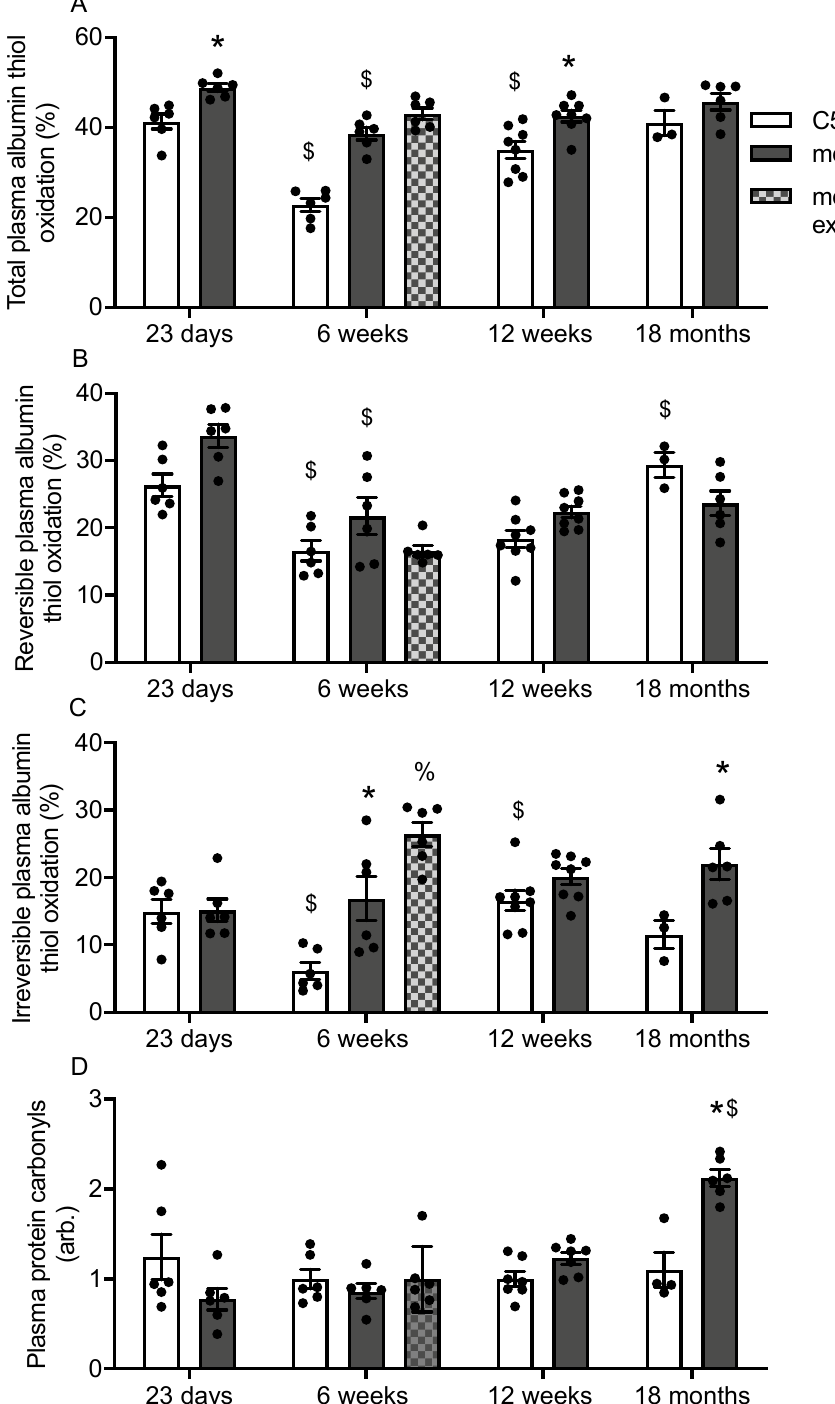
Figure 3. Total albumin thiol oxidation ( A ), reversible albumin thiol oxidation ( B ), irreversible albumin thiol oxidation ( C ) and protein carbonylation ( D ) in C57 and mdx plasma at various time points. * = significantly ( p < 0.05) different to age matched control. % = significant ( p < 0.05) different to unexercised 6 week old mdx. $ = significantly ( p < 0.05) different to previous age group of same strain. Bars represent mean ± SEM and n = 5–8 per